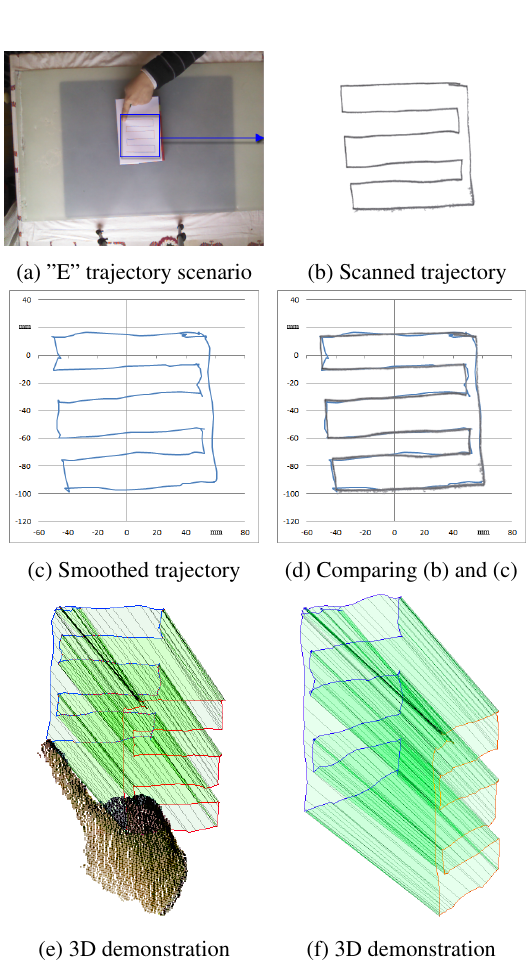
Figure 10: Tracking a pointing hand form (171 frames) Table 1: Computation time of major algorithms or